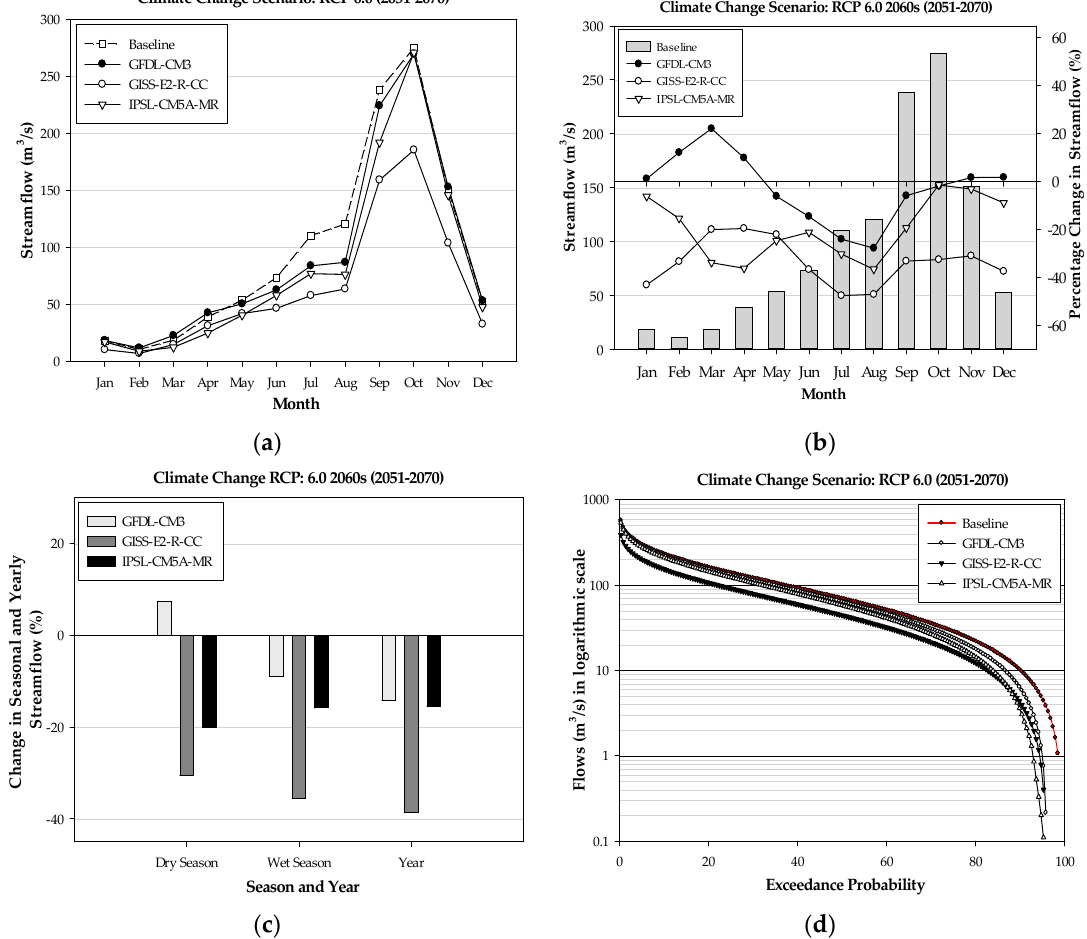
Figure 7. ( a ) The comparison of baseline and future streamflow, ( b ) The change in future streamflow, ( c ) The change in seasonal and annual streamflow, ( d ) The exceedance probability of flow. Table 7. Percentage changes in Q 5 and Q 95 during the future time